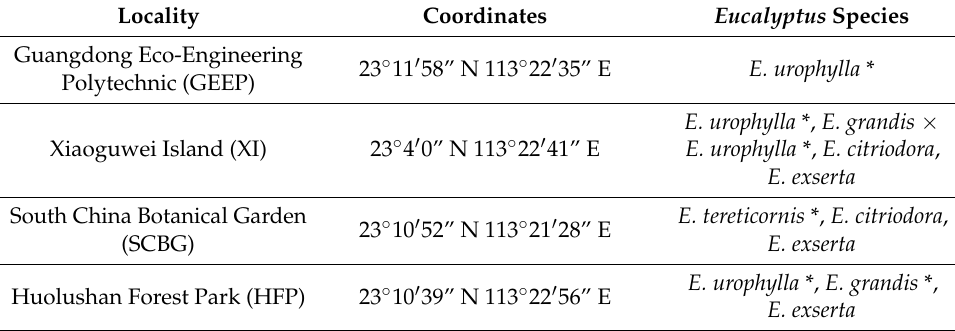
Table 1. Details of surveyed localities and Eucalyptus species. Locality Coordinates Eucalyptus